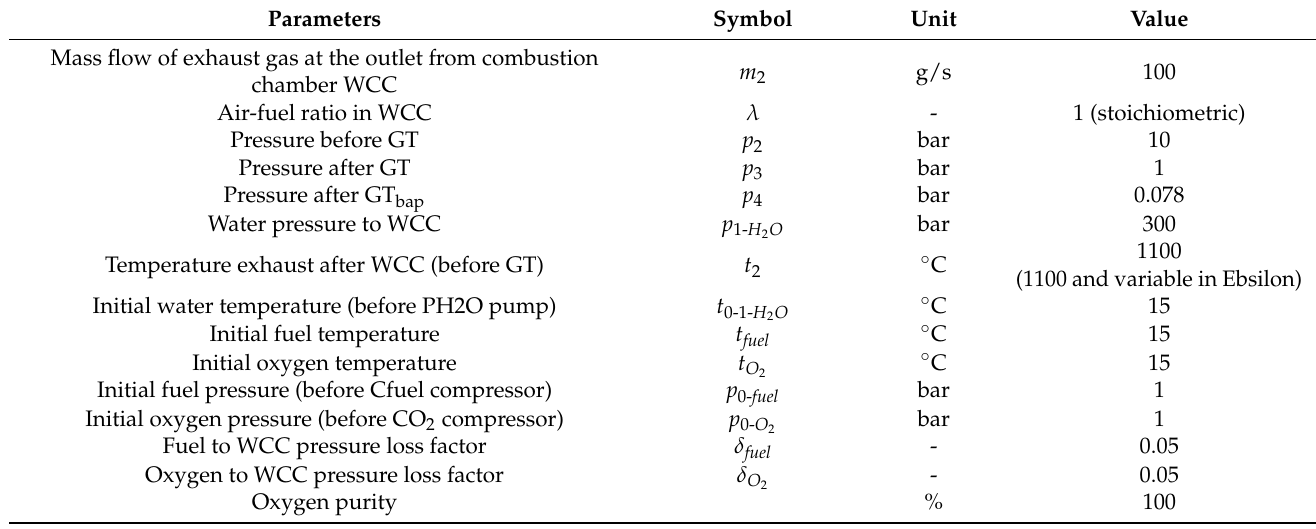
Table 3. Assumptions for the thermodynamic cycle calculation using Aspen HYSYS, Aspen Plus, and